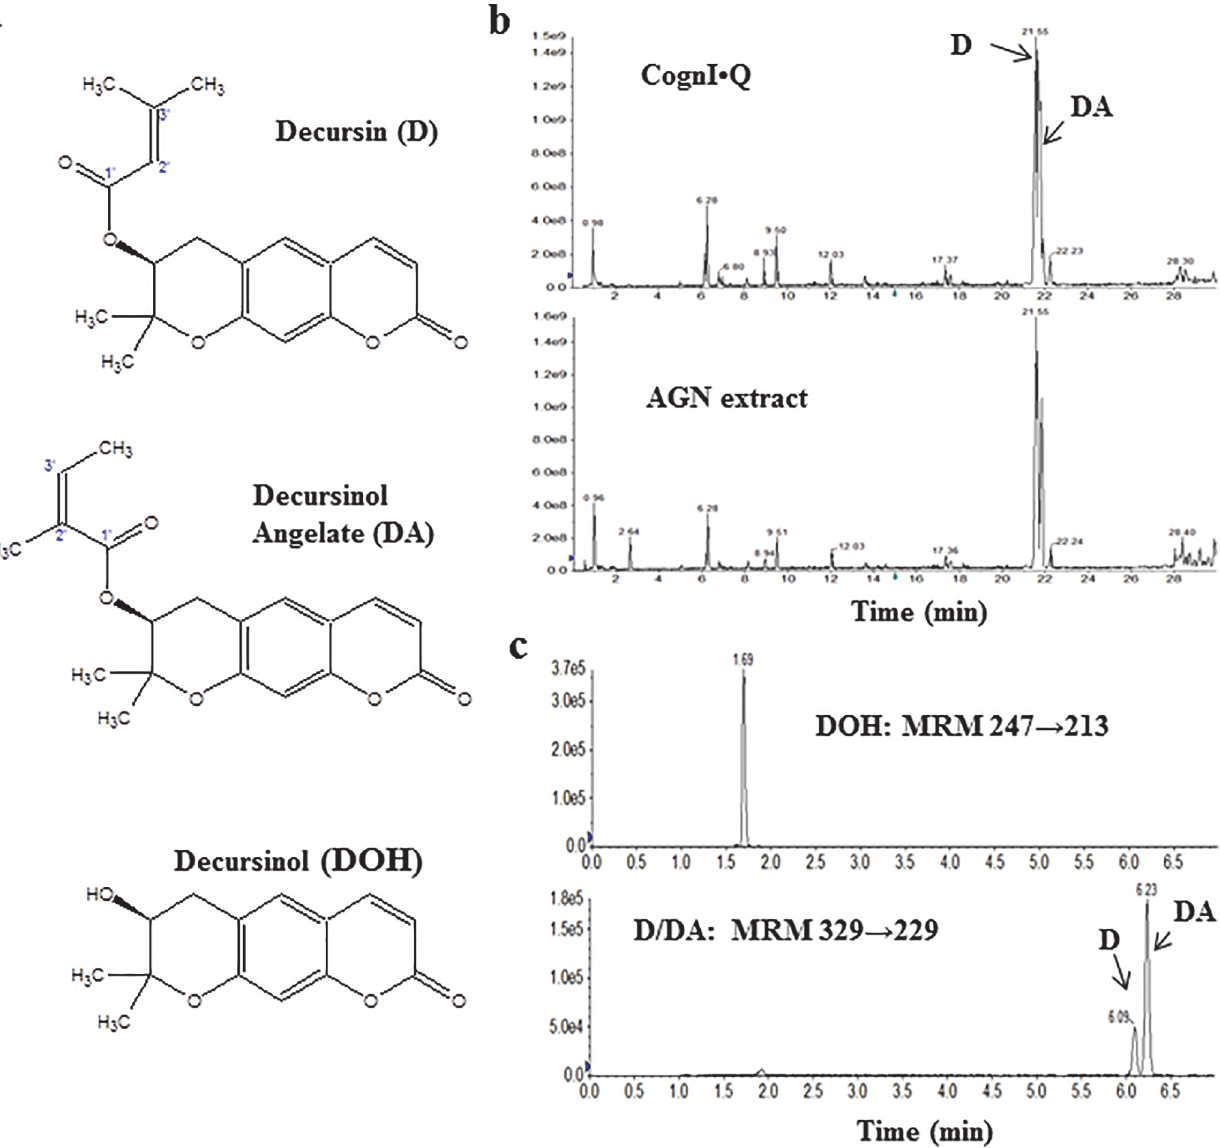
Fig 2. Chemical structures of pyranocoumarins, UHPLC characterization of test material Cogni.Q and example of UHPLC analysis of a plasma sample. a) Structure of decursin (D), decursinol angelate (DA) and decursinol (DOH); b) Chemical fingerprinting of Cogni.Q and AGN extract by UHPLC-MS/ MS in full scan mode (EMS scan); c) Typical chromatograms of D, DA and DOH in human plasma by UHPLC-MS/MS in MRM